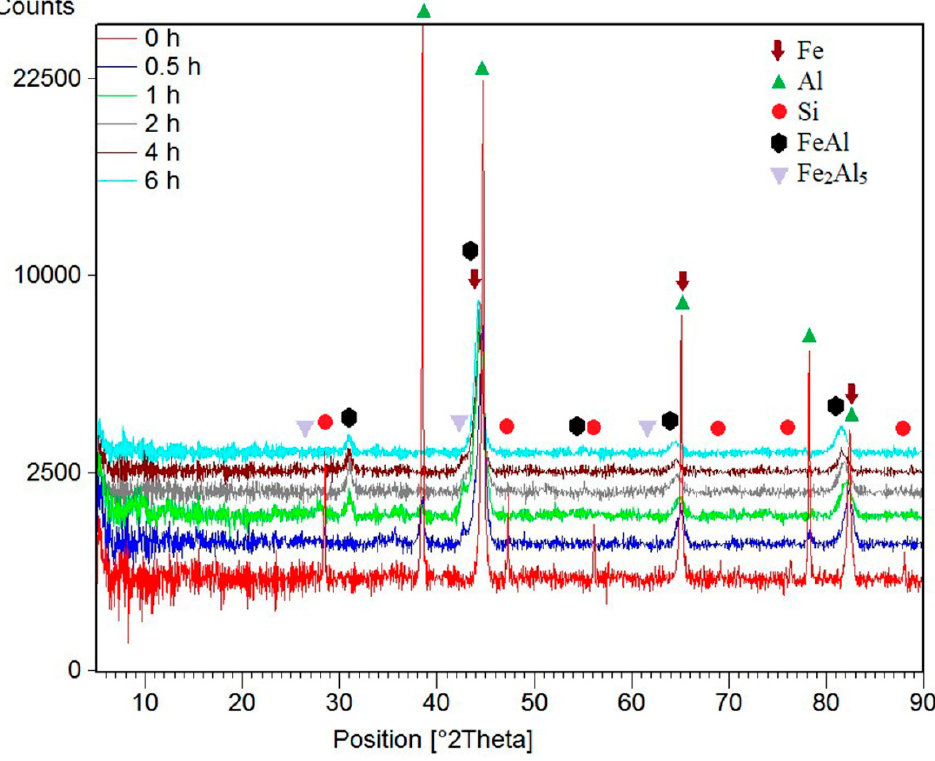
Figure 1. Phase composition of FeAl35Si5 alloy vs. milling time. Table 1. Phase composition vs. milling time for FeAl35Si5 alloy.